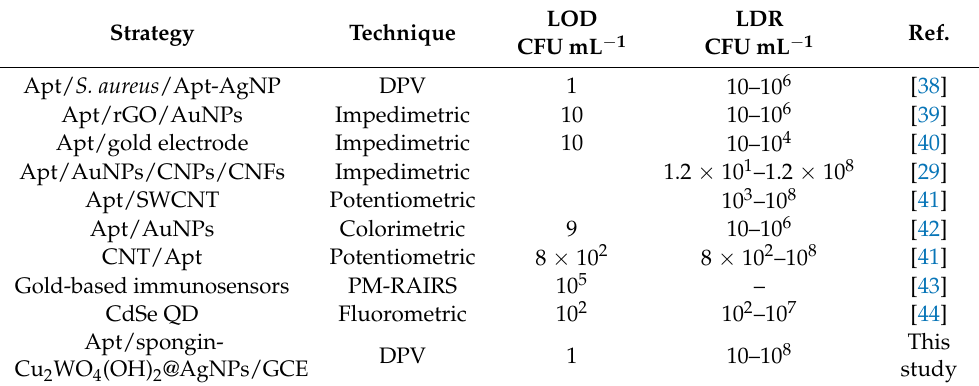
Figure 6. The DPVs of the aptasensor after incubation of 1.5 × 10 7 CFU mL − 1 of ( a ) S. aureus , ( b ) S. flexneri , ( c ) E. coli , and ( d ) Salmon for 30 min in 0.1 M PBS containing 0.1 M KCl and 1 mM ([Fe(CN) 6 ] 3 − /4 − ) as the redox marker. Table 1. A comparison of the analytical performance of the aptasensor with some reported sensors and aptasensors in S. aureus detection.